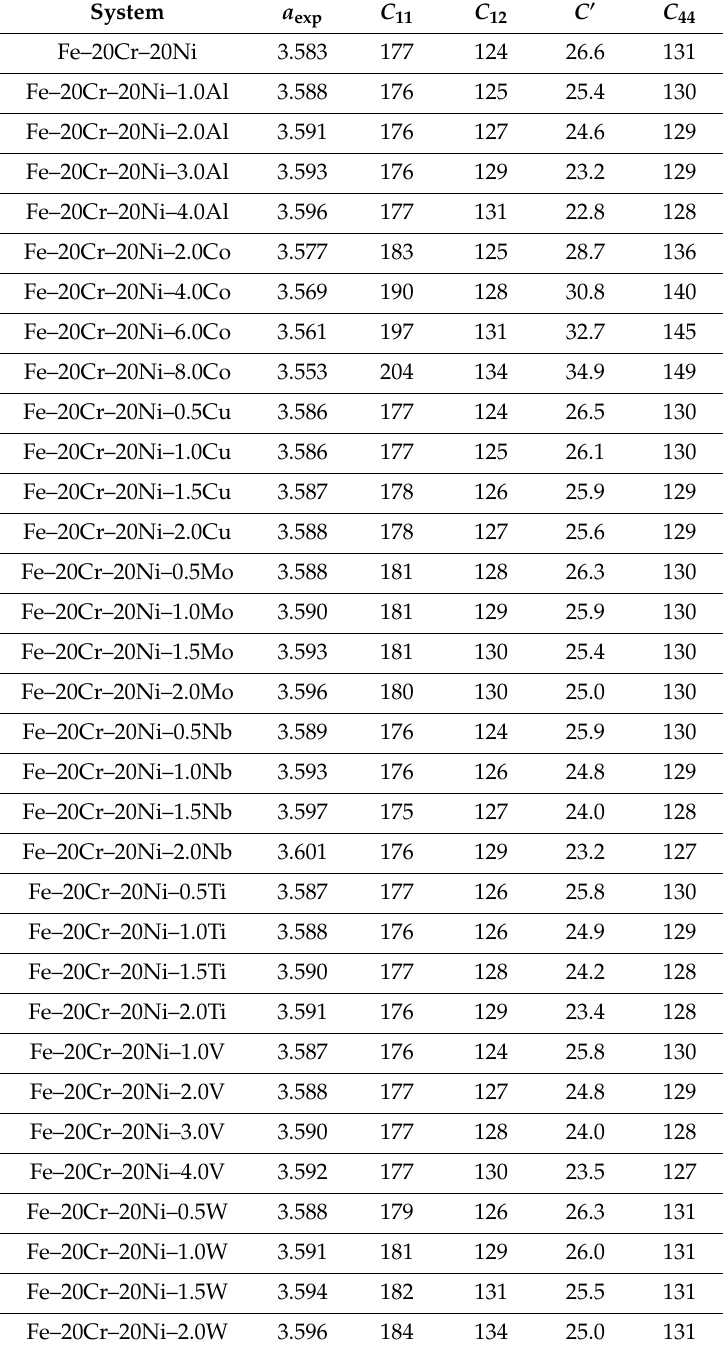
Theoretical (EMTO) single-crystal elastic constants (in GPa) for paramagnetic fcc Fe–20Cr–20Ni– x %M (M = Al, Co, Cu, Mo, Nb, Ti, V, and W; 0 ≤ x ≤ 8, where x is in atom %) alloys calculated at their lattice parameter a exp (in Å) estimated from Equation